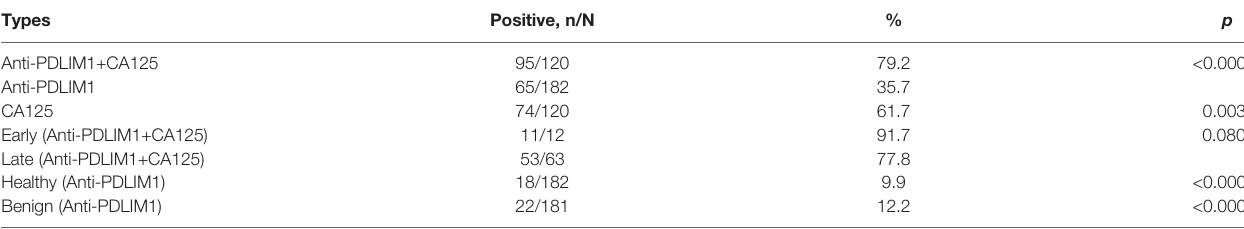
TABLE 4 | Diagnostic performance of anti-PDLIM1 AAb, CA125, and the combination of